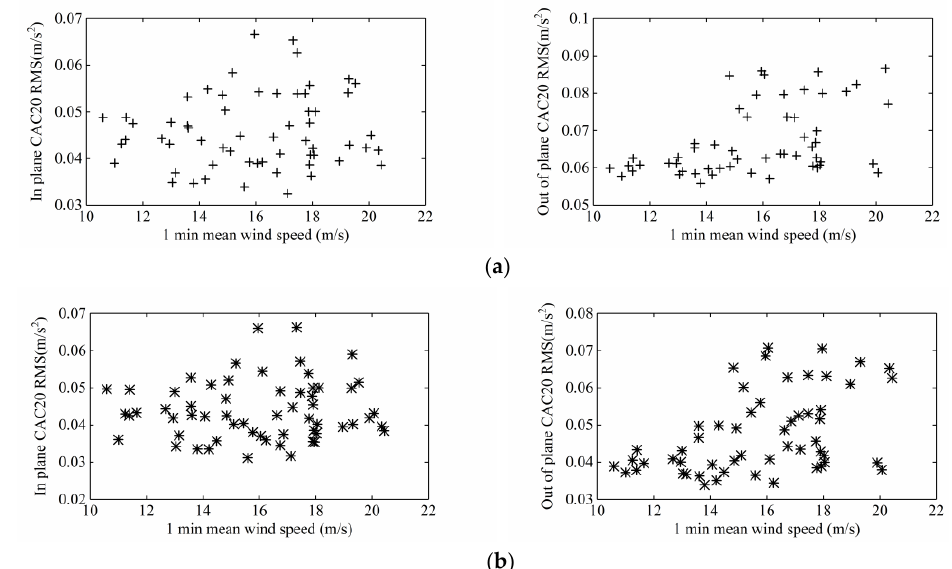
Figure 13. Root mean square stay cable acceleration response versus mean wind speed: ( a ) Upstream; ( b ) Downstream.